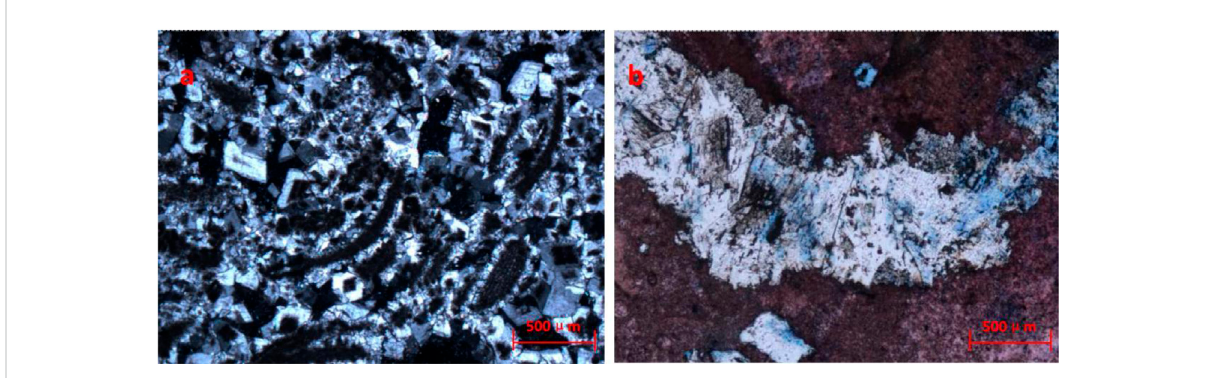
FIGURE 4 Petrological characteristics of deep dolomites. (A) microscopic characteristics of bright edge of dolomite fog center, 1170.42 m, diagonal lengthof1.6 mm(XN); (B) mediumandcoarse-grainedsaddledolomiteis fi lledinthelimestonefracture.Thedolomitecanseefogcenterandbright edge,singlepolarization,1239.42 m(1N);Fromtheoveralltrend,cementdolomitesandexcessivedolomitizedfog-brightedgedolomitesarewidely distributedinWellXike1.Thegreatertheburialdepth, thegreaterthedolomitecontent,andthenumberofdolomitecrystalsincreaseswiththe increase of burial depth. In addition, the order degrees of dolomites in theWell Xike 1 range from 0.4355 to 0.6000, and generally increases with the increase of the burial depth (Shi et al., 2016). The change of dolomite content from shallow to deep layers re fl ects the self adjustment process of dolomite structures from recrystallization to ideal composition in the process of